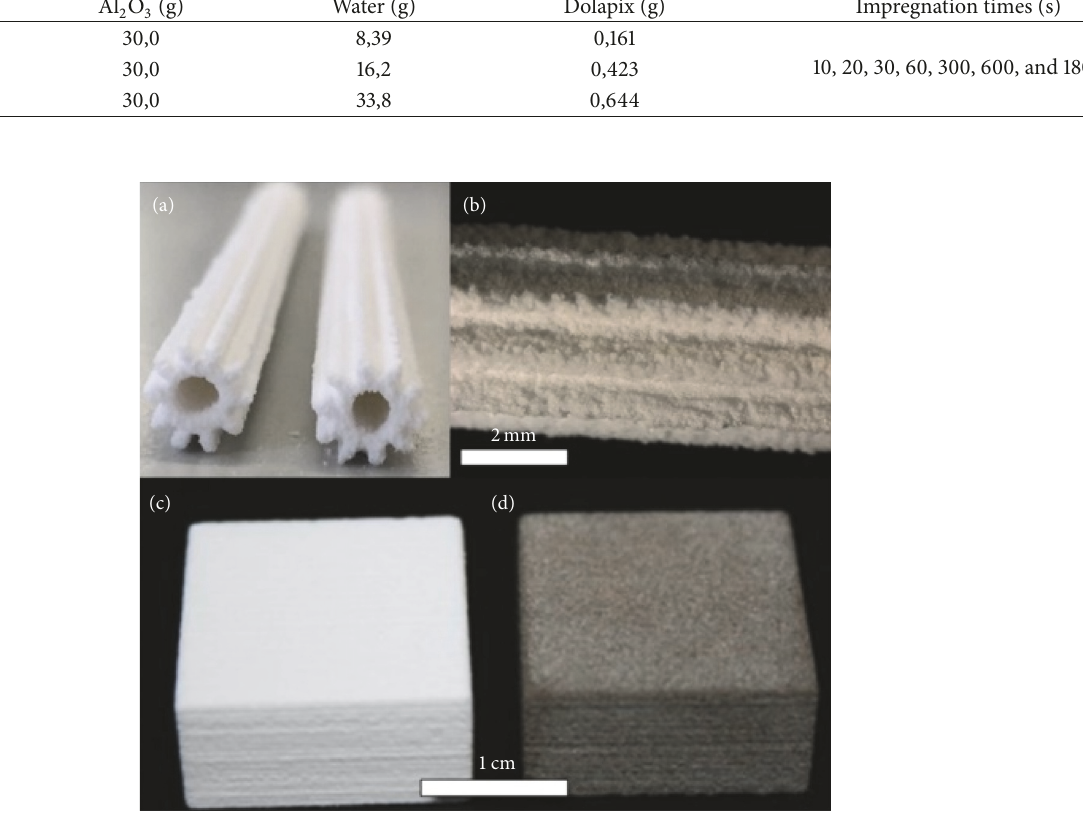
Figure 3: ((a) and (b)) 3D printed supporting structures in CaSO 4 . (c) 3D printed square testing pieces in the green state and (d) after firing at 250 ∘ C for 3h.